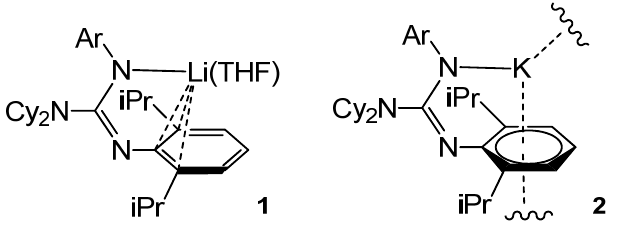
Figure 3. Lithium and potassium compounds with η 6 -arene coordination.